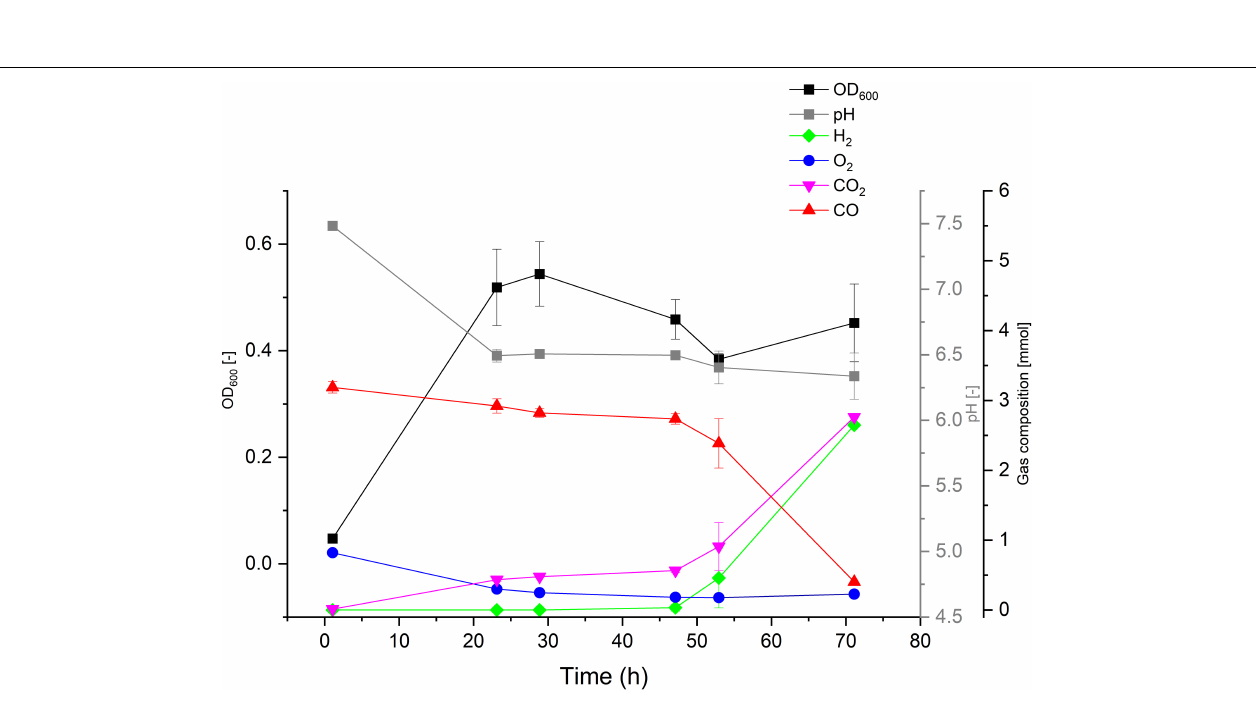
FIGURE 2 | Gas composition and growth of P. thermoglucosidasius Kp1013 cultivated under 50% carbon monoxide and 50% air in 250 ml serum bottles containing 50 ml of mLB medium.